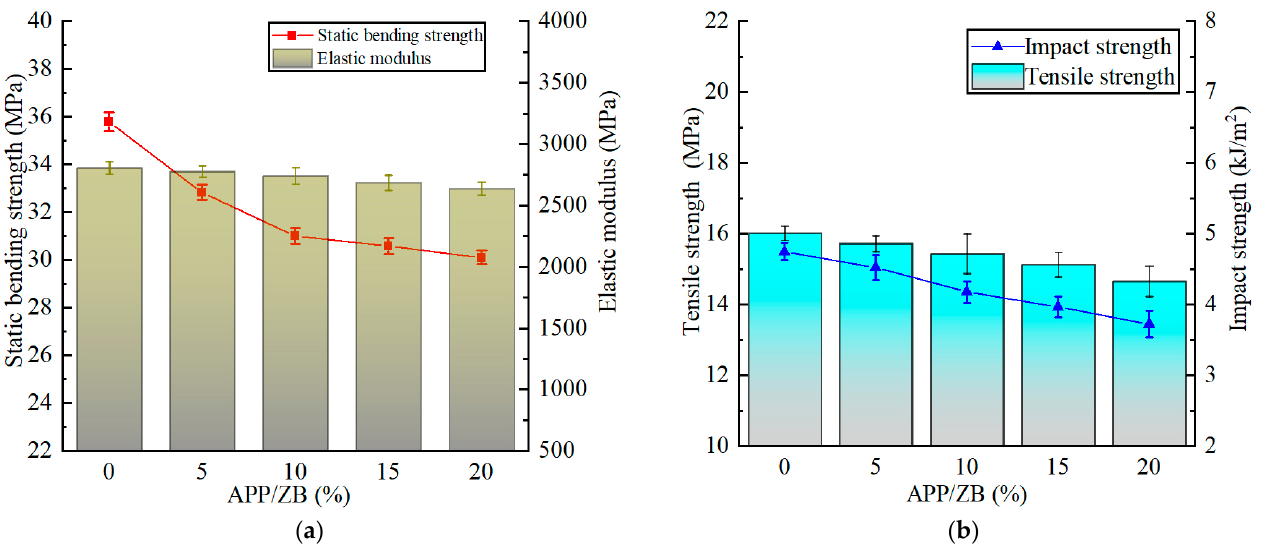
Figure 1. E ff ect of di ff erent APP/ZB content on static bending strength and elastic modulus ( a ). Ef- Figure 1. Effect of different APP/ZB content on static bending strength and elastic modulus ( a ). fect of di ff erent APP/ZB content on tensile strength and impact strength ( b ). Effect of different APP/ZB content on tensile strength and impact strength ( b